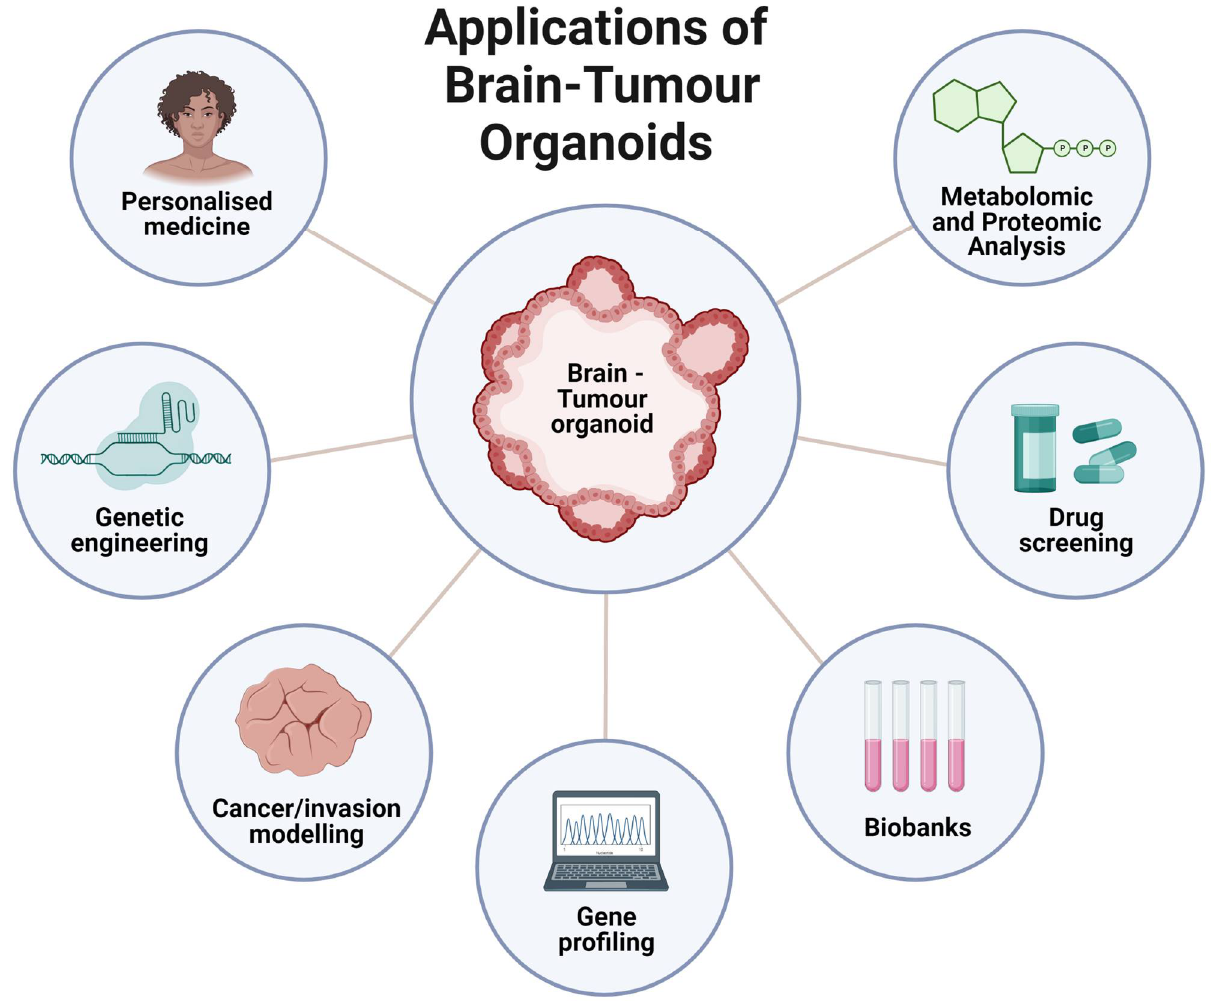
Figure 1. Applications of Brain-Tumour Organoids. Recent advances in cell culture technology have allowed the use of organoids as model systems for a myriad of applications such as personalised medicine, genetic engineering, cancer and invasion modelling, gene profiling, primary cell/tumour biobanks, drug screening, and metabolomic/ proteomic analyses. Created with Biorender.com accessed on 25 September 2022.